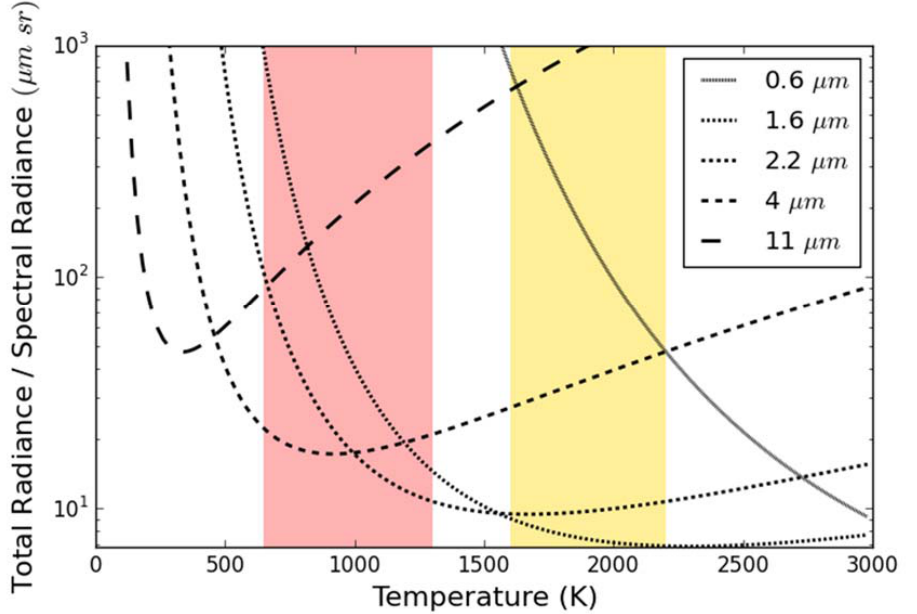
Figure 1. Ratios of radiant emittance (Stefan’s law) to spectral radiant emittance (Planck’s law) for different blackbody emitter temperatures at wavelengths commonly used by satellite Earth-imaging radiometers. A constant ratio at a given wavelength indicates that the Planck function can be well approximated by a 4th order power law over the defined temperature domain and that mapping from spectral radiance at that wavelength to total radiant emittance is possible using a constant term. Coloured regions represent combustion temperature domains common in landscape fires (in red) and in gas flares (in yellow). The dashed lines represent the wavelength used in the calculation of the spectral radiance. Note the log scale and the near constant ratio of total radiance to spectral radiance at MIR wavelengths for landscape fire combustion temperatures and similar behaviour at SWIR channels for gas flare combustion temperatures.